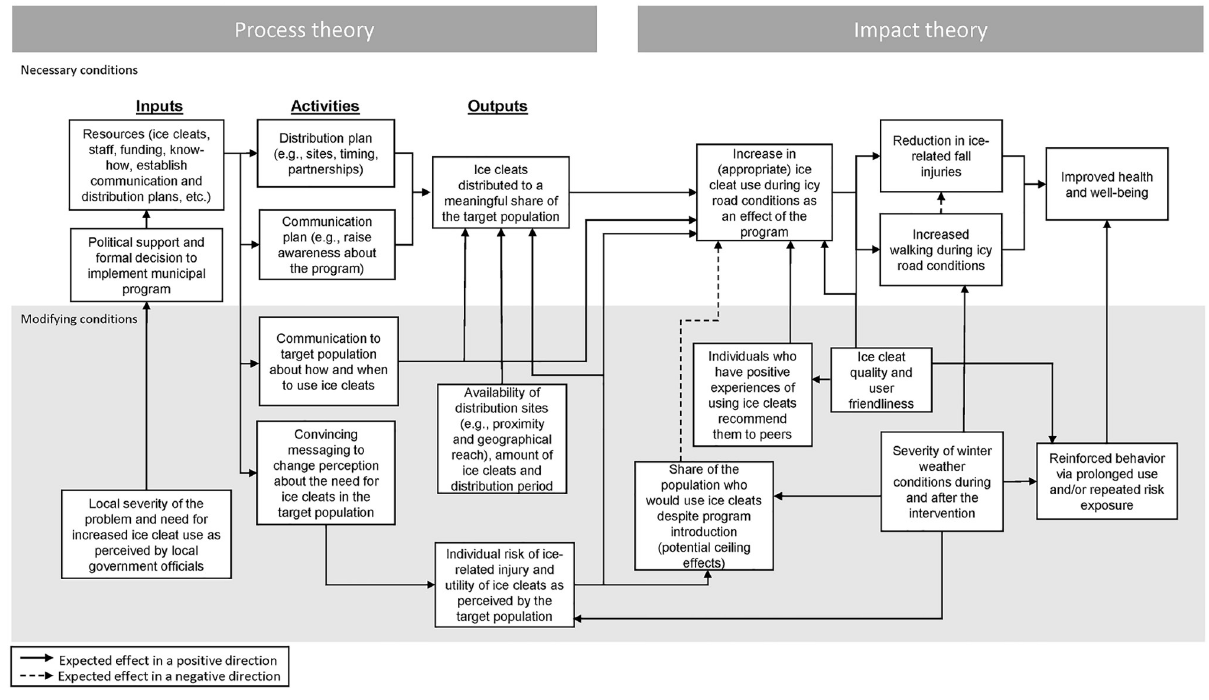
Fig 1. Hypothesized necessary and modifying conditions for a successfully implemented municipal ice cleat program.